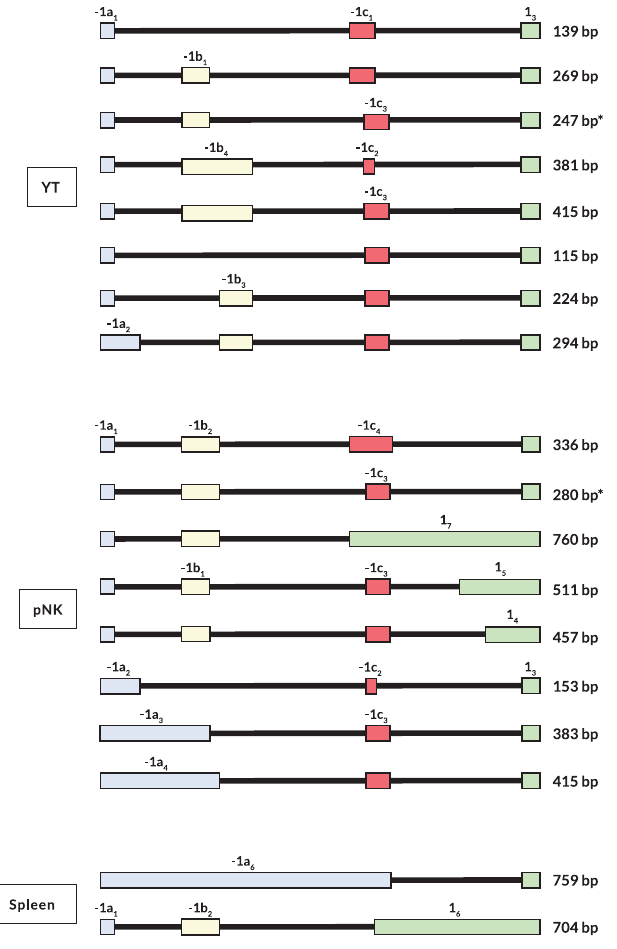
Fig 2. Variable 5´ UTRs detected in the human YT cell line, peripheral blood NK, and spleen. A schematic diagram of exon content observed by sequencing of PCR products generated using an exon -1a forward primer and an exon 1 3 reverse primer located upstream of the HLA-C start codon. The relative size and position of exons in the 1.3 kb region upstream of the HLA-C start codon is shown. The size of each amplicon is listed on the right of each transcript. The asterisk indicates the most abundant splice form observed in YT or pNK cDNA. Only novel transcripts not found in YT cDNA are shown for pNK, and unique cDNAs not found in either YT or pNK are shown for spleen.